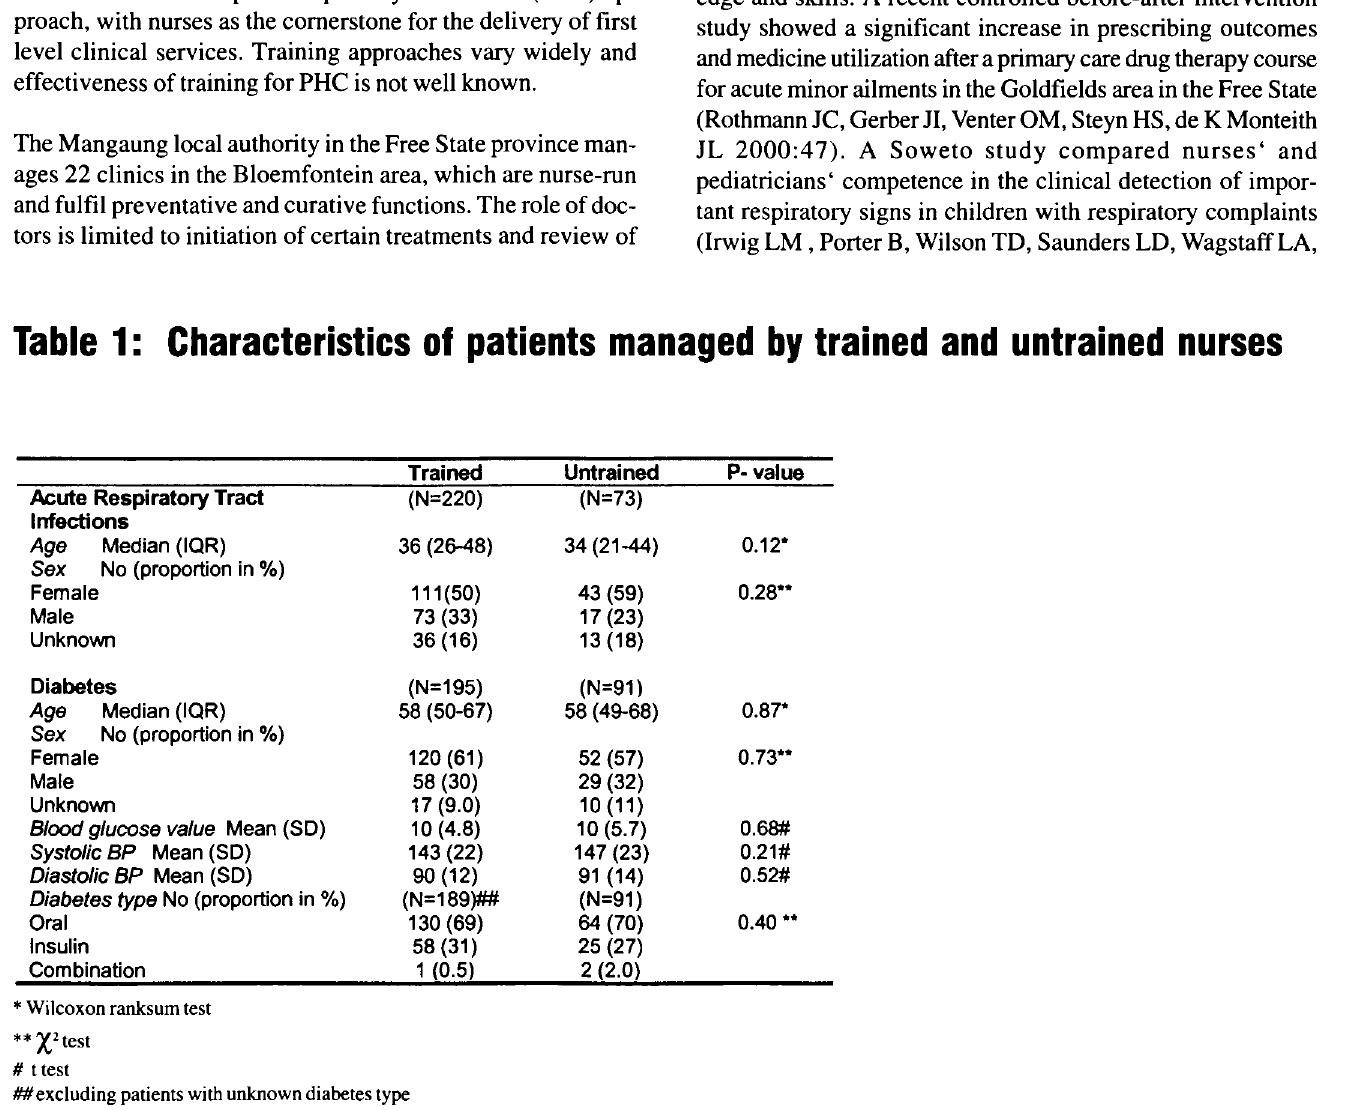
Characteristics of patients managed by trained and untrained nurses